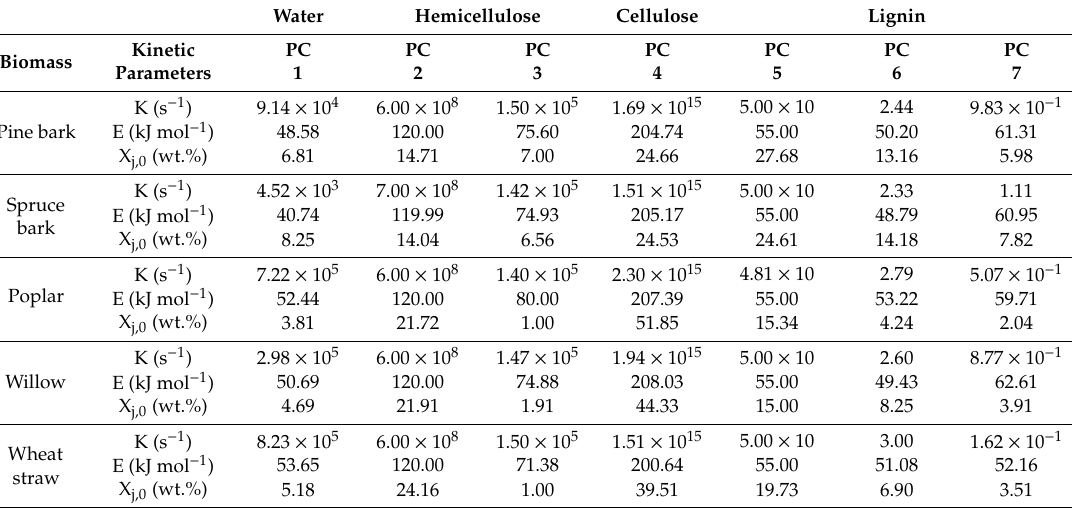
Table 6. Kinetic parameters of the pseudocomponents.